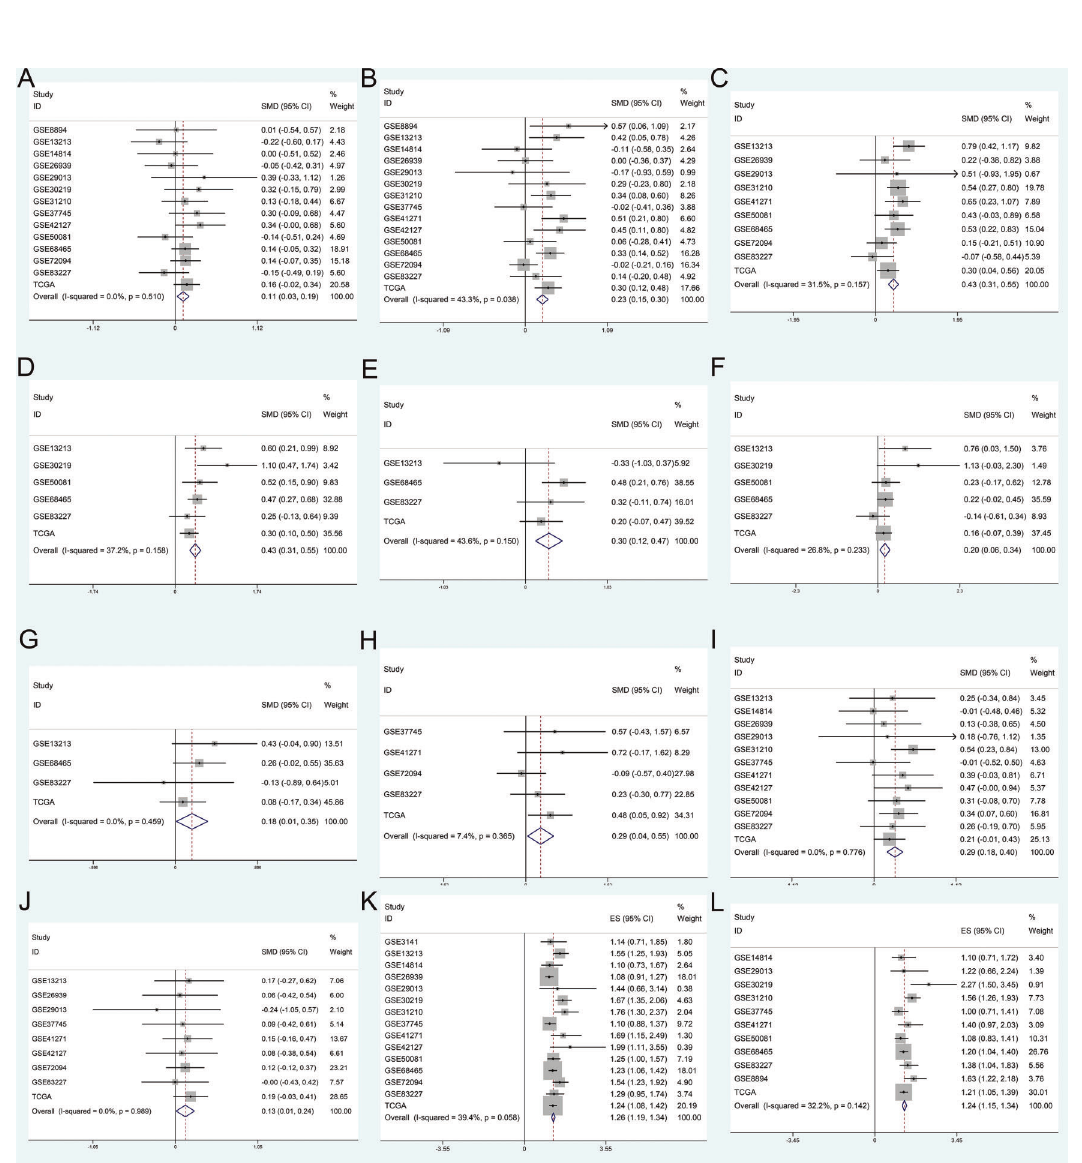
Figure 2 - The results of the meta-analysis for the association of ZWINT expression with patient ( A ) age ( o =65/ 4 65), ( B ) sex (male/ female), ( C ) smoking status (yes/no), ( D ) T stage (T2/T1), ( E ) T stage (T3-T4/T1-T2), ( F ) N stage (N1/N0), ( G ) N stage (N2-N3/N0-N1), ( H ) M stage (M1/M0), ( I ) AJCC stage (stage II/stage I), ( J ) AJCC stage (stage III-IV/stage I-II), ( K ) OS, and ( L ) PFS.